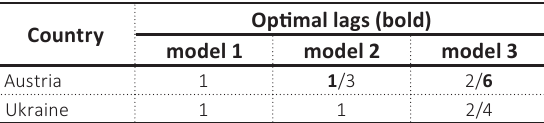
Table 10. Determining the optimal number